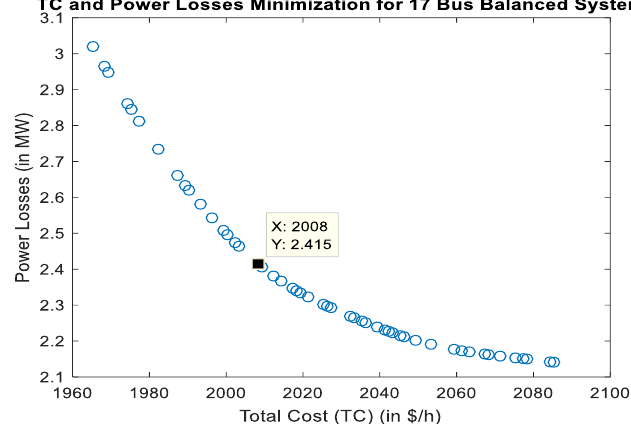
Figure 3. Pareto optimal front (POF) and trade-off solution for balanced 17 bus DS.